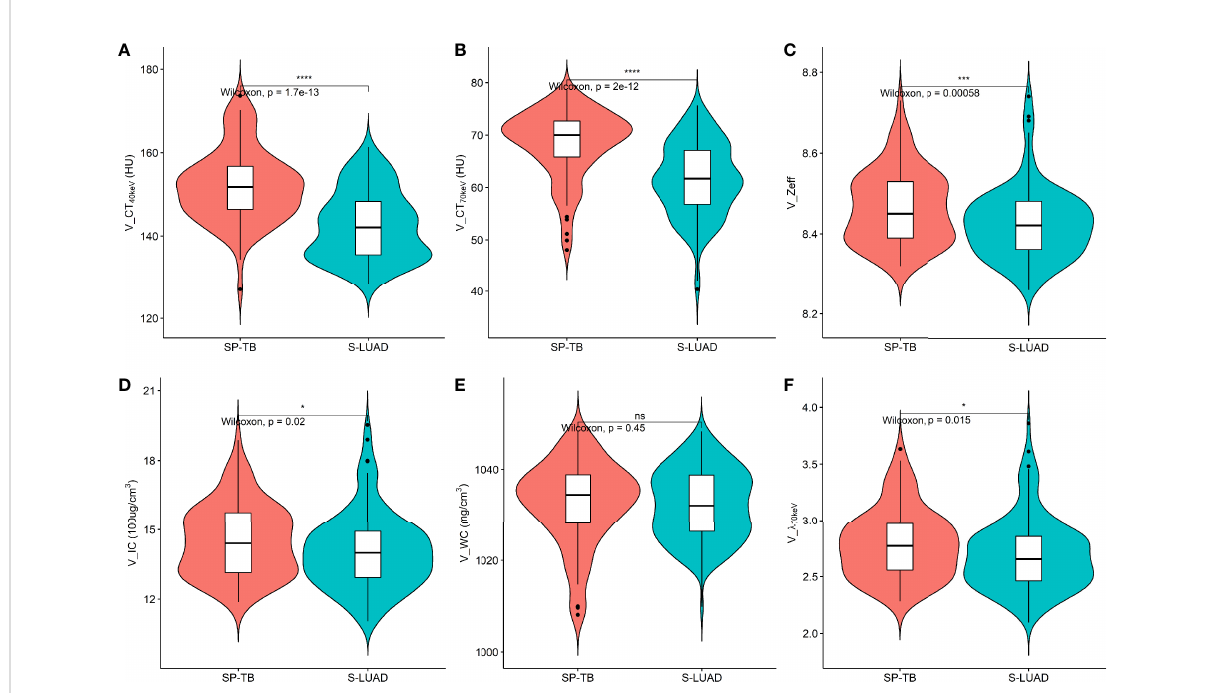
FIGURE 4 Violin plots of dual-energy spectral CT multiparameter for solitary pulmonary tuberculosis (SP-TB) and solitary lung adenocarcinoma (S-LUAD) in the venous phase. (A) CT 40 keV value; (B) CT 70 keV value; (C) effective atomic number (Zeff); (D) iodine concentration (IC); (E) water concentration (WC); (F) spectral curve slope ( l 70 keV ). * P < 0.05; *** P < 0.001; **** P < 0.0001; Ns, No signi fi